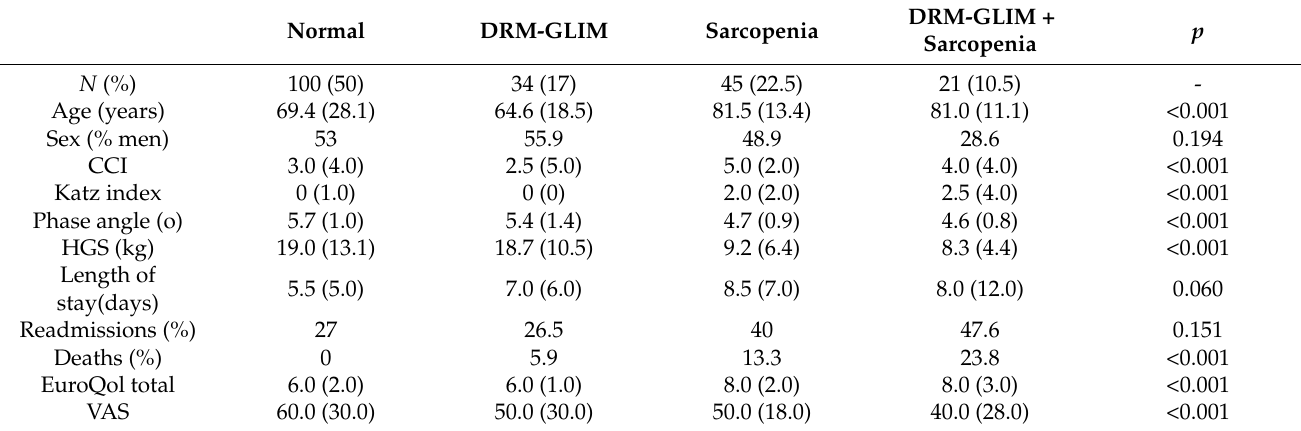
Data expressed as medians (Interquartile range) or % and compared by Kruskal–Wallis test; CCI = Charlson comorbidity index; HGS = handgrip strength; VAS = EuroQol Visual analogue scale (ranges 0–100); EuroQol total range